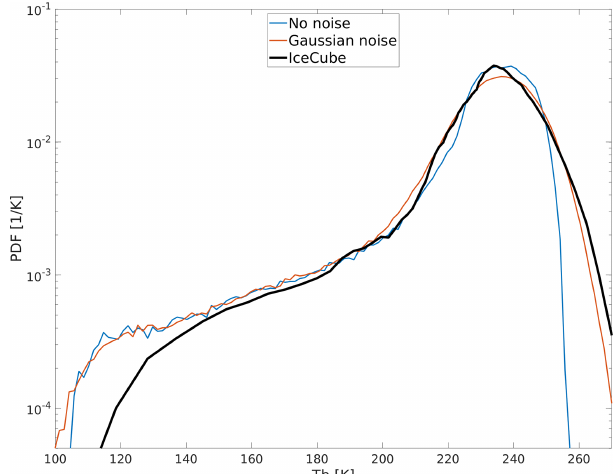
Figure E1. PDF comparisons of IceCube TB (black) against ARTS model simulations using DARDAR retrieved IWC profiles as the input (blue) and the same simulation with 7K Gaussian random noise applied (red). Only DARDAR profiles that are within the same area and time range of Fig. 7 are used and the simulation follows Ekelund et al.